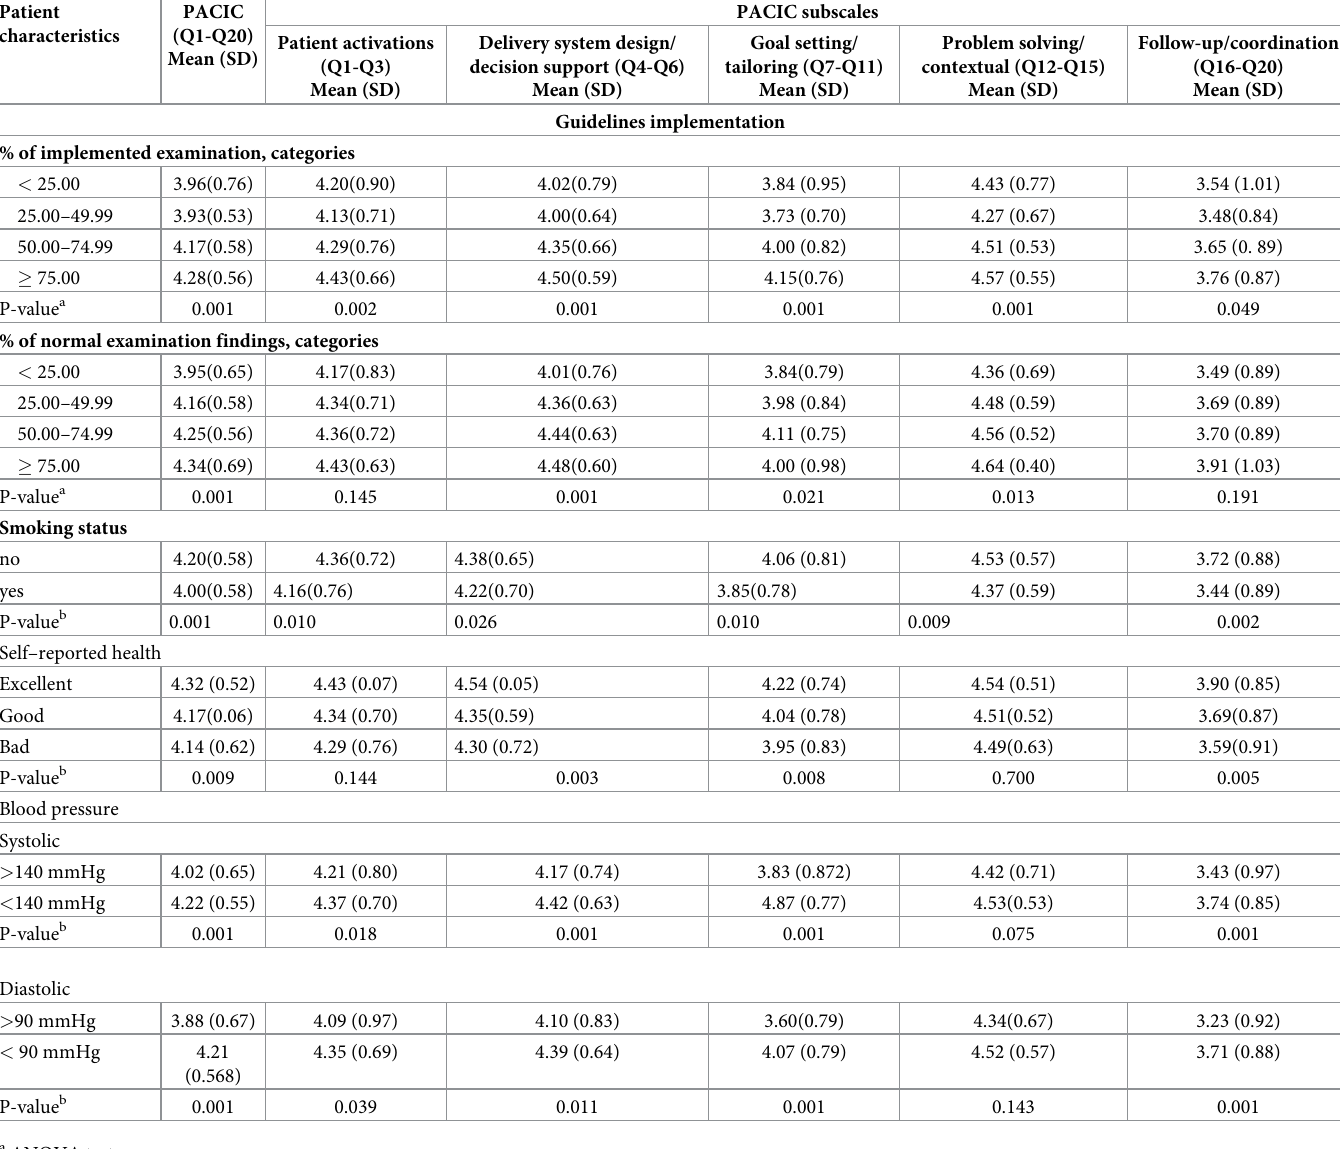
Table 3. PACIC overall and subscales scores in patients with hypertension in family